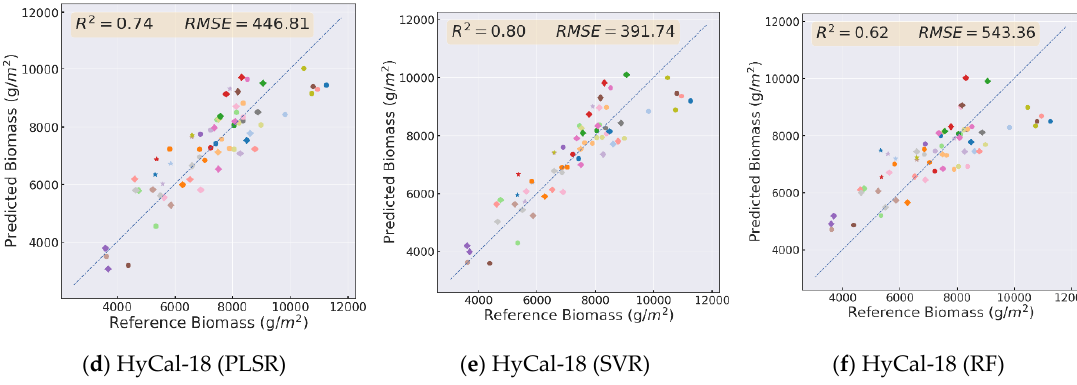
Figure 20. Prediction results of PLSR, SVR, and RF models developed for the HyCal-17 and HyCal-18 experiments, using all the data sources and leaving-one-out cross validation strategy.